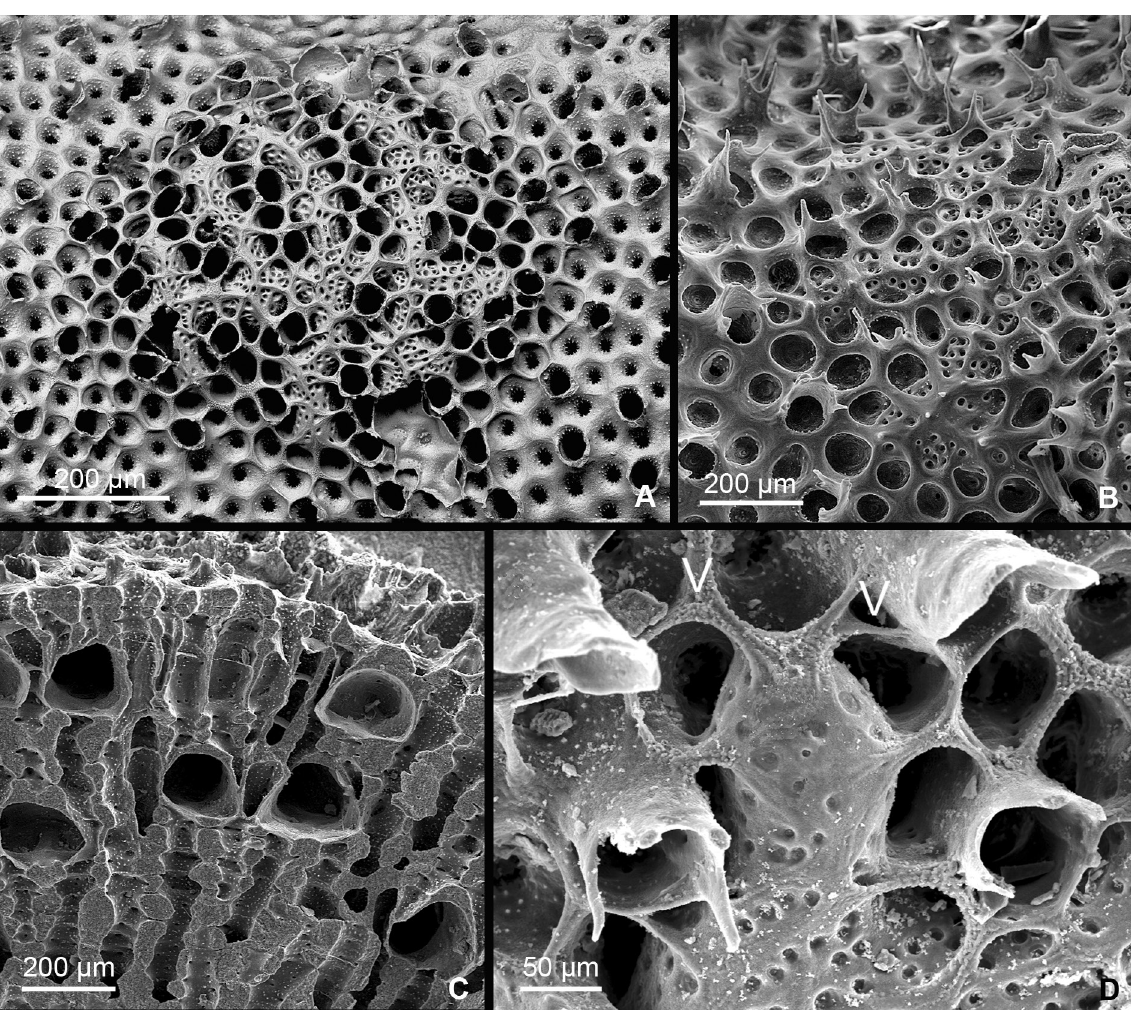
Fig. 5. Brood chambers in Disporella guada Harmelin, Taylor & Waeschenbach sp. nov. A . Paratype (NHMUK 2021.2.25.1). B–D . Holotype (MNHN-IB-2017-696). A . Brood chamber with 8 lateral branches, thinly covered by secondary calcification. B . Thicker mesh of secondary calcification over a brood chamber. C . Transverse section of branch intersecting six lobes of ramifying brood chambers. D . Two ooeciopores (open arrowheads) at the end of a lateral branch of a brood